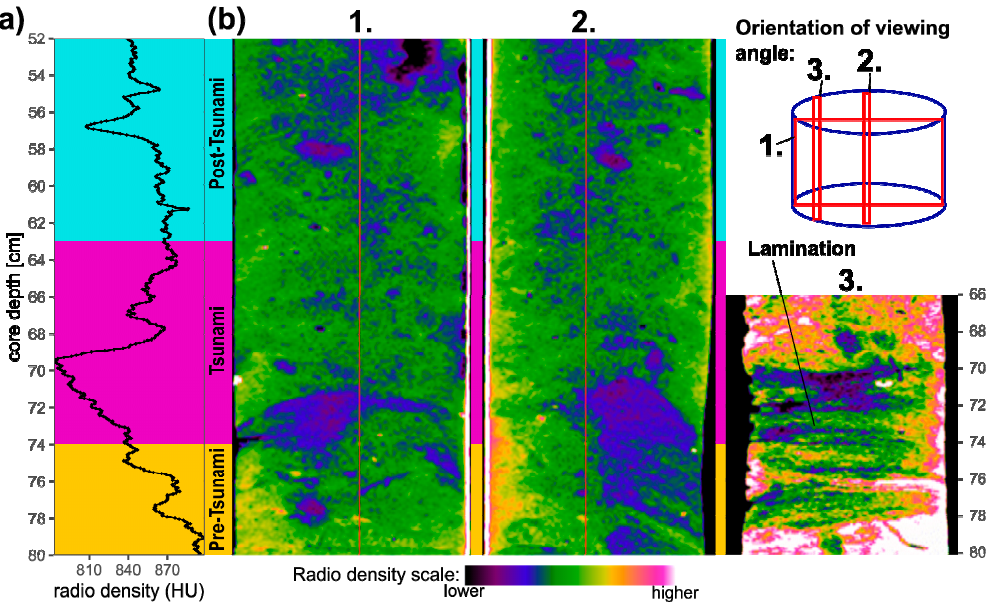
Figure 7. Radio density values (HU) ( a ) and computed tomography (CT) images ( b ) of core M106 in